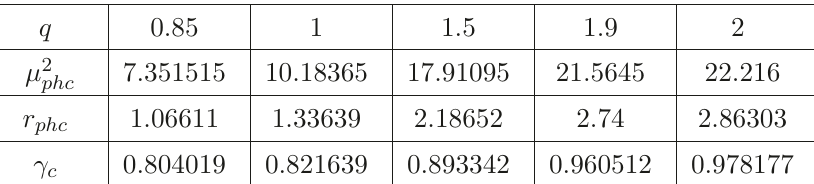
γ diagram for different YM charges and M = −